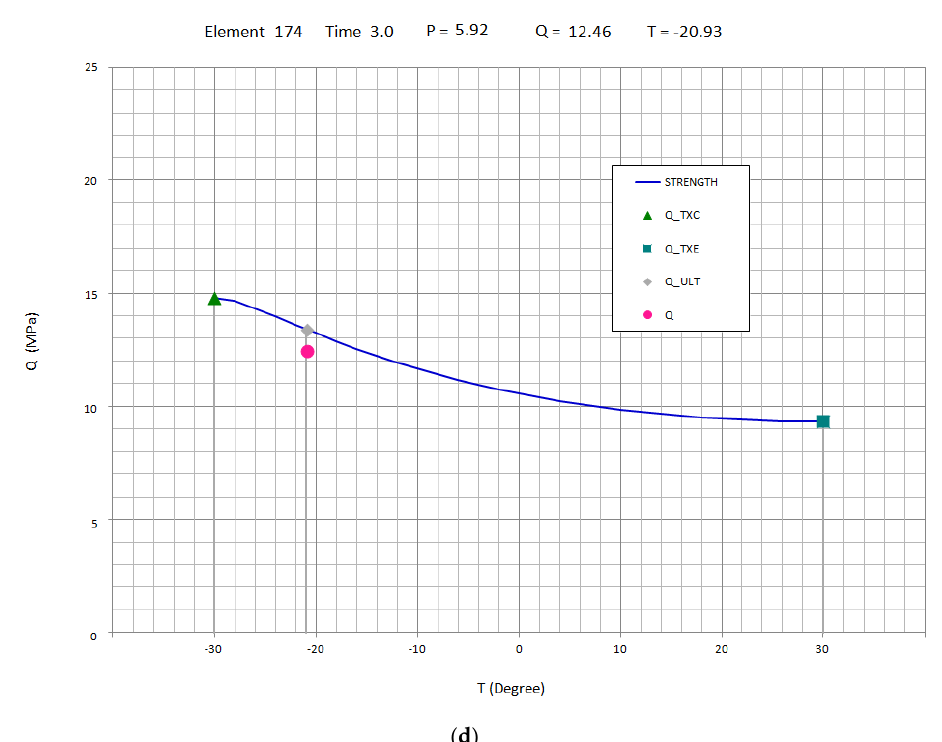
Figure 17 . Stress state at the first element along lines C5 and D6 (Ko = 2.0): ( a ) p – q plot at Location Figure 17. Stress state at the first element along lines C5 and D6 (Ko = 2.0): ( a ) p–q plot at Location C; C; ( b ) t – q plot at Location C; ( c ) p – q plot at Location D; ( d ) t – q plot at Location D. ( b ) t–q plot at Location C; ( c ) p–q plot at Location D; ( d ) t–q plot at Location